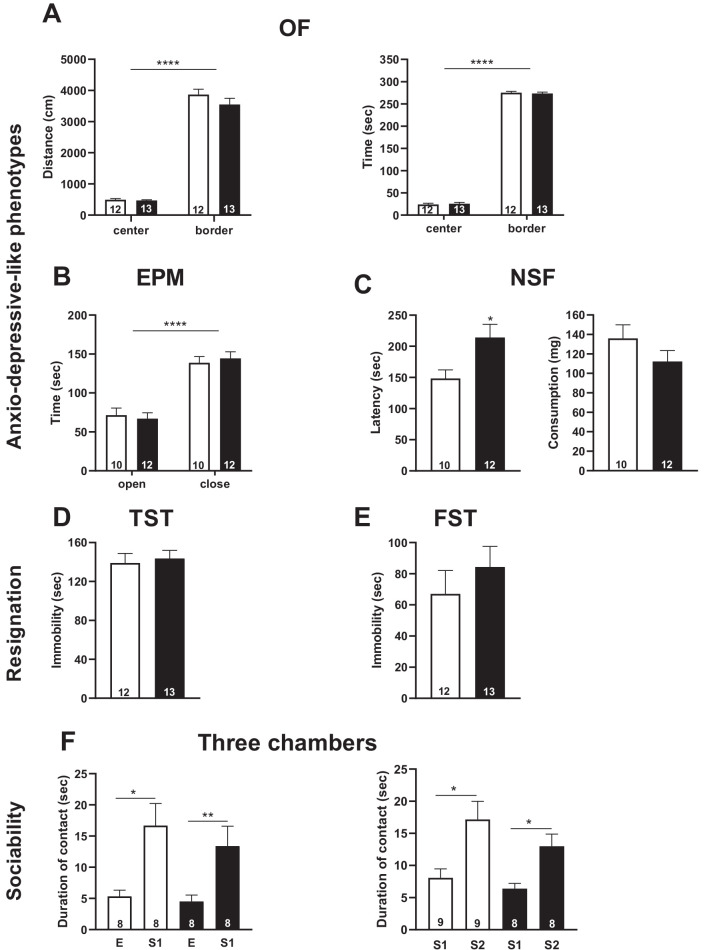
Snord115-deficient mice do not display abnormal anxio-depressive-like phenotypes and show normal response to sociability stimuli.Cohorts of adult Snord115-deficient males (black bars) and their WT littermates (white bars) were subjected to Open field (A), Elevated plus maze (B), Novelty supressed feeding (C), Tail suspension (D), Forced swimming (E) and Three chambers (F) tests. The number of individuals analyzed are indicated within histograms. Note that due to tracking issues, one WT individual was omitted from analysis (4F-left-panel). None of these analyses showed a significant effect of genotype (ANOVA p-values>0.05 for genotype in each panel).